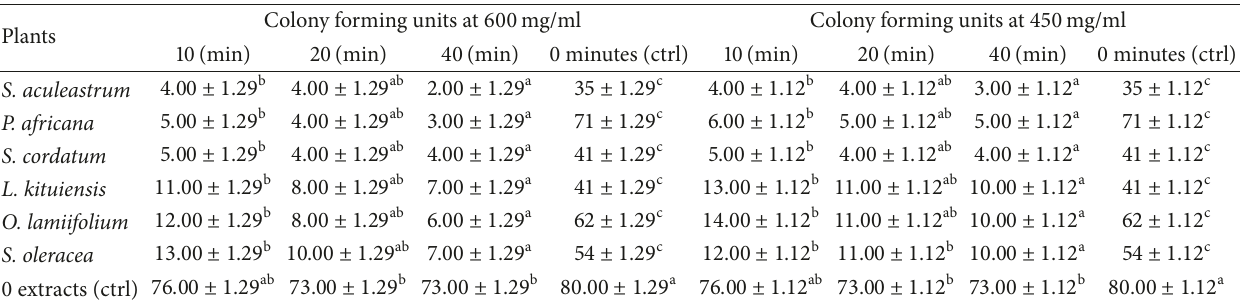
Table 3: Effect of aqueous plant extracts and photosensitization on Aspergillus flavus (UONV017). Colony forming units at 600 mg/ml Colony forming units at 450 Plants